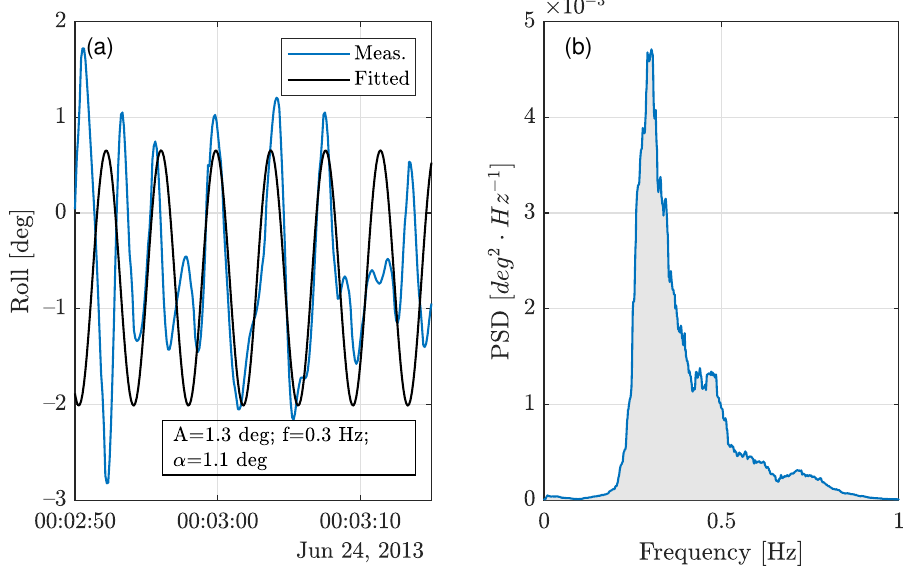
Figure 4. The FDWL motion characterization as a sinusoidal signal: roll motion example (PdP, 24 June 2013, 00:00 LT). ( a ) The 10 min roll time series (blue trace) and fitted sinusoidal signal (black trace). ( b ) PSD of the panel ( a ) time